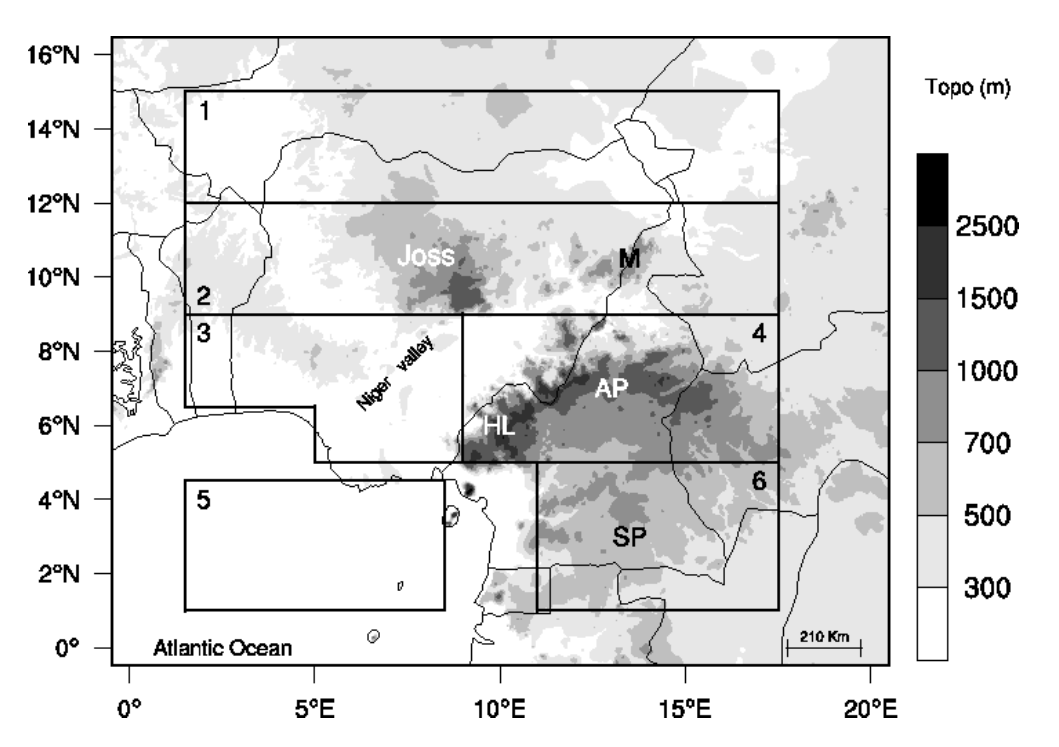
Figure 1. The general surface elevation of the Central Africa based on GTOPO30 2 min topographic data (m). Solid lines delineate the geographical regions used for assessing the diurnal cycle of convective activity. Letters indicate most elevated areas, AP: Adamaoua Plateau, HL: West Cameroon Highlands, M: Mandara, SP: South Cameroon